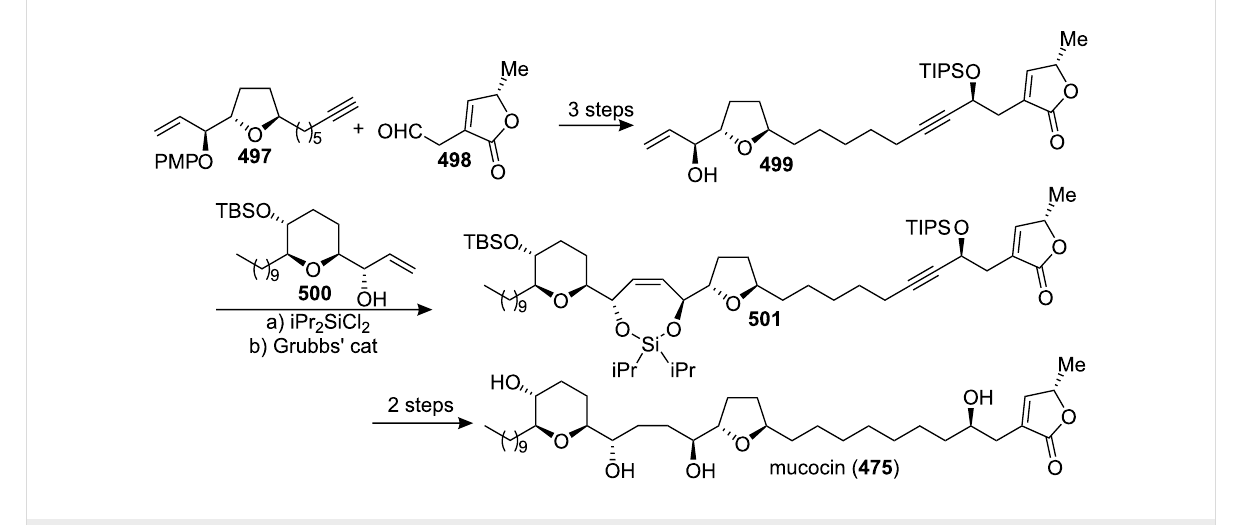
Scheme 72: Total synthesis of mucocin by Evans’s group.